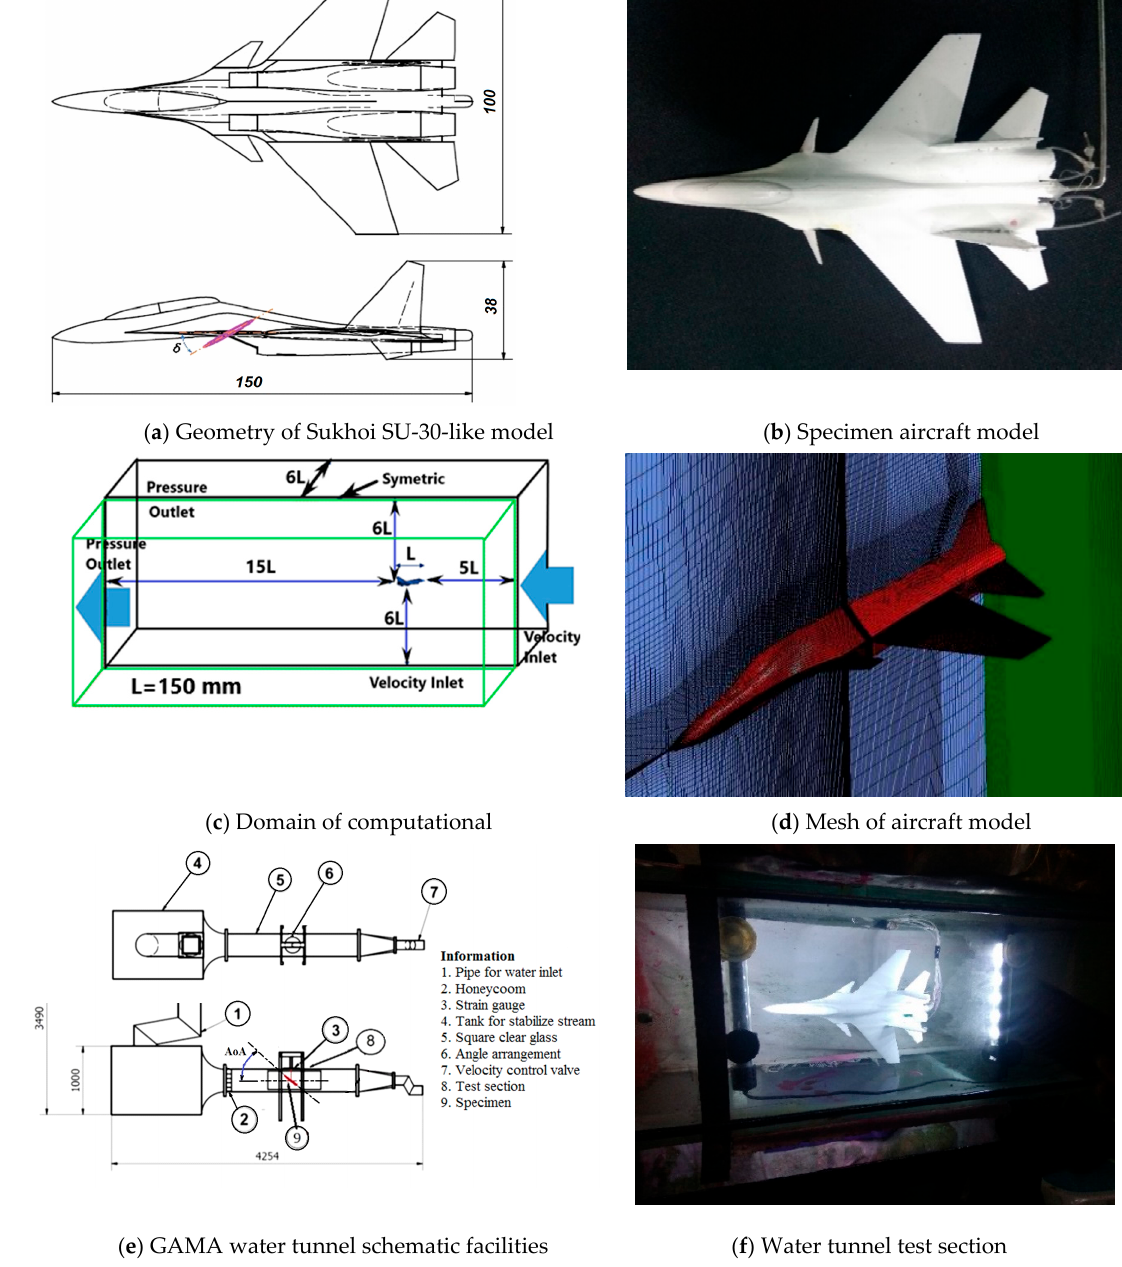
Figure 1. Boundary condition, mesh configuration, and water tunnel flow visualization